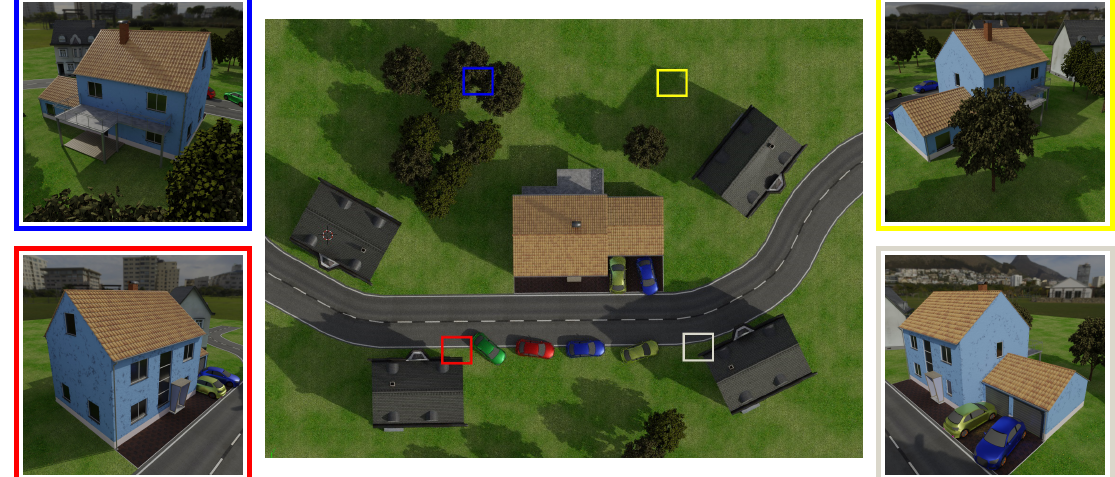
Figure 6. Overview of our synthetic scene used in our experiments ( mid ). Sample views of the building for the highlighted areas are shown in the left and right